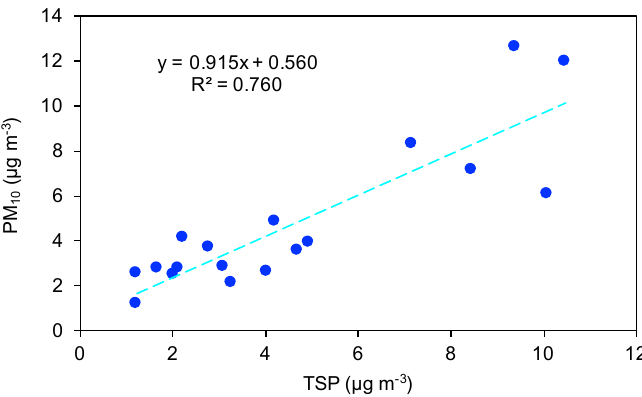
Figure 3. Linear correlation between PM 10 and TSP during AREX2011 ( n = 19).